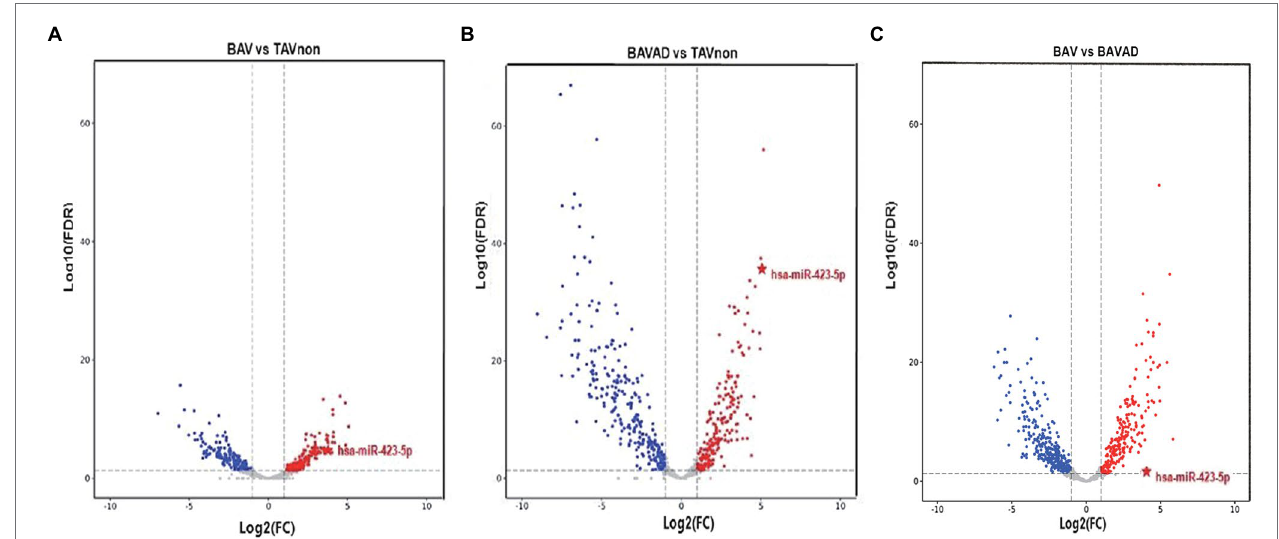
FIGURE 1 | The volcano plot of differential expression levels of the plasma exosome miRNAs between different groups. (A) BAV group and TAVnon group. (B) BAVAD group and TAVnon group. (C) BAV group and BAVAD group. The log 2 (fold change) is plotted against the − log 10 ( p value).